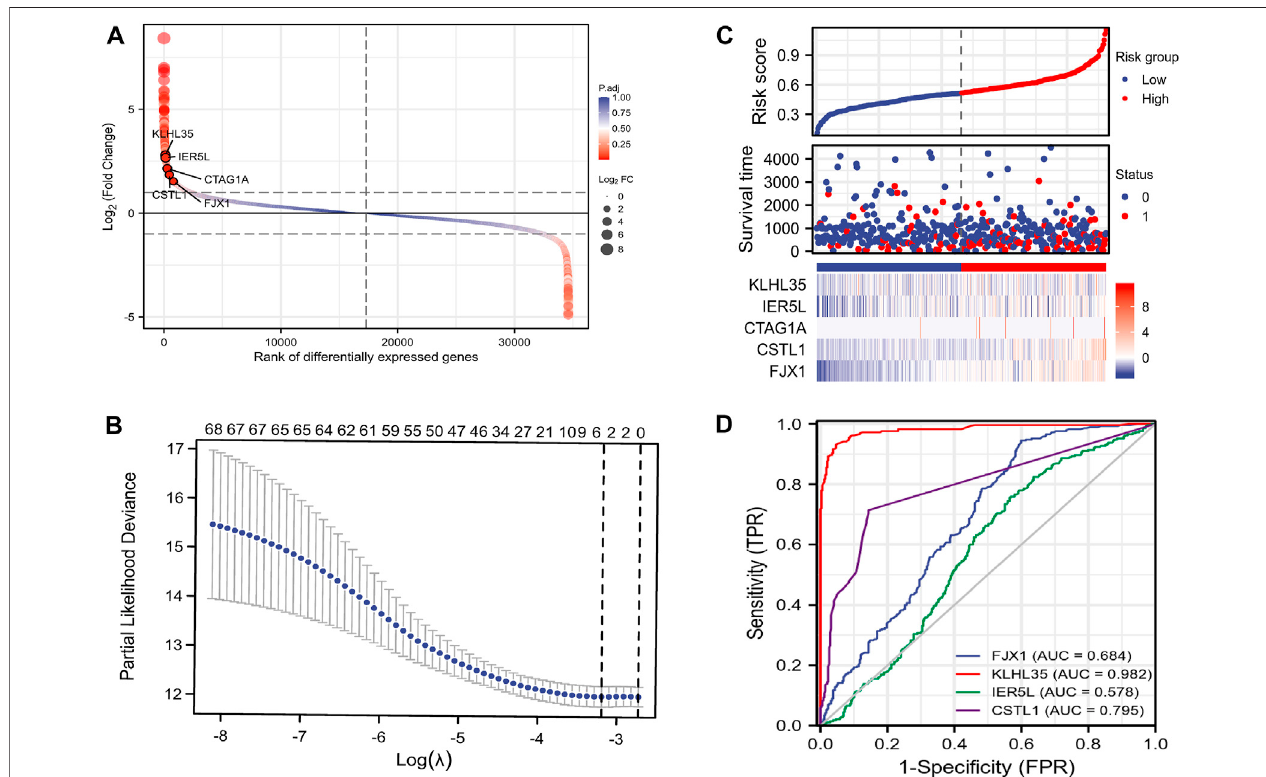
FIGURE 3 | Construction of the prognostic model. (A) Disparity map. (B) Lasso prognostic model. (C) Risk factor map. (D) ROC curve.